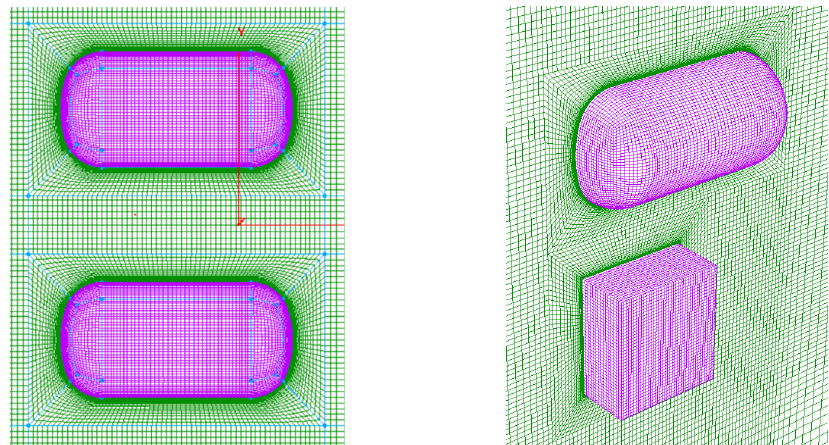
Figure 5. Schematic diagram of grid on wall and symmetry plane of multi-body flow field around irregular disintegration.